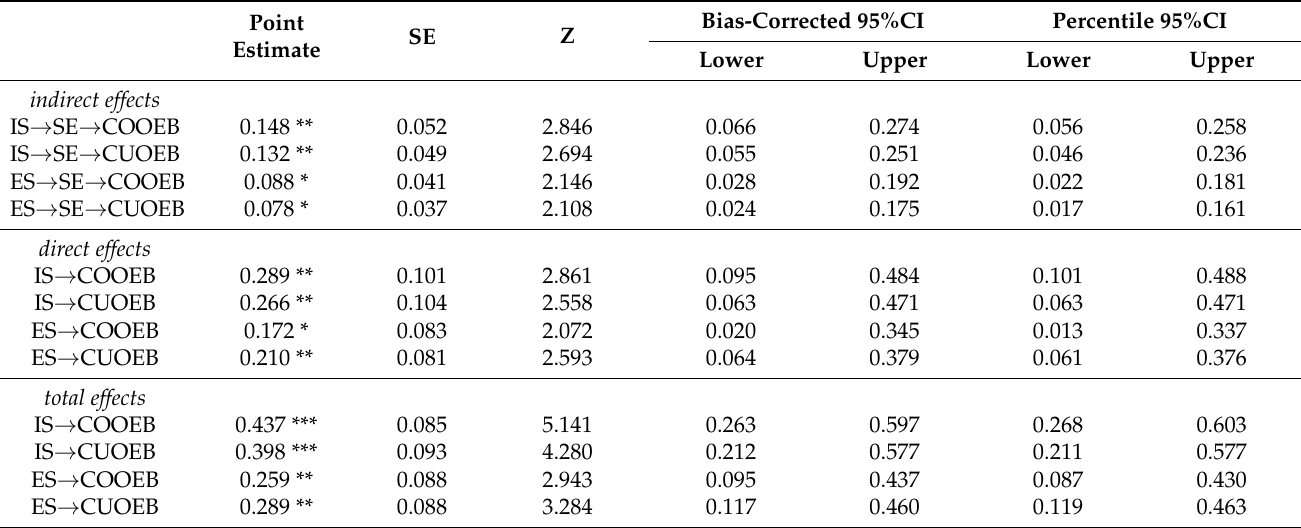
Table 4. Standardized direct, indirect, and total effects of the mediation model.